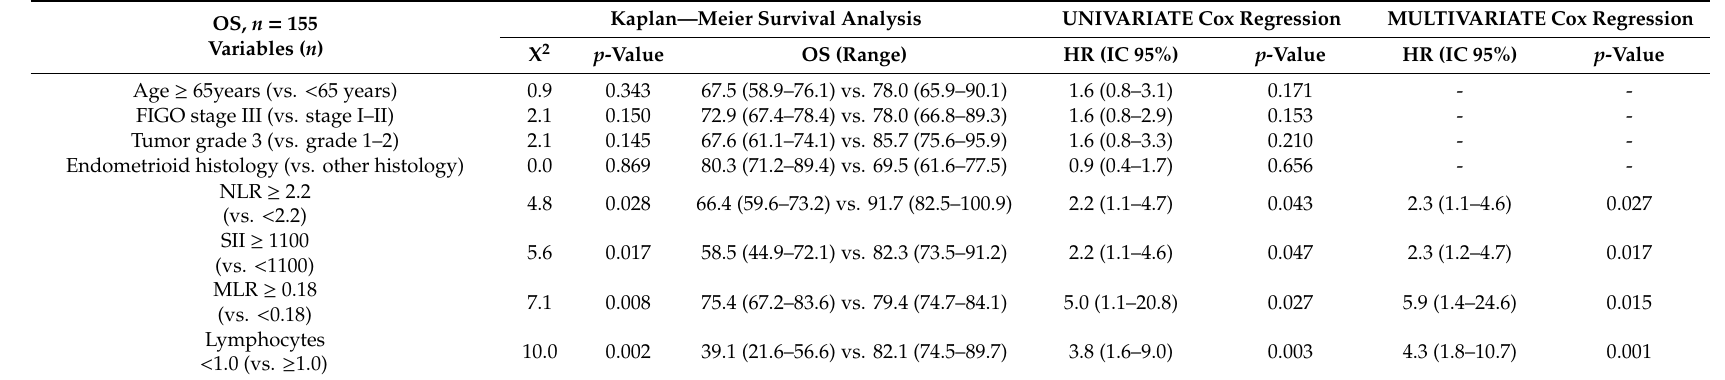
Table 1. Overall survival analysis ( n = 155).